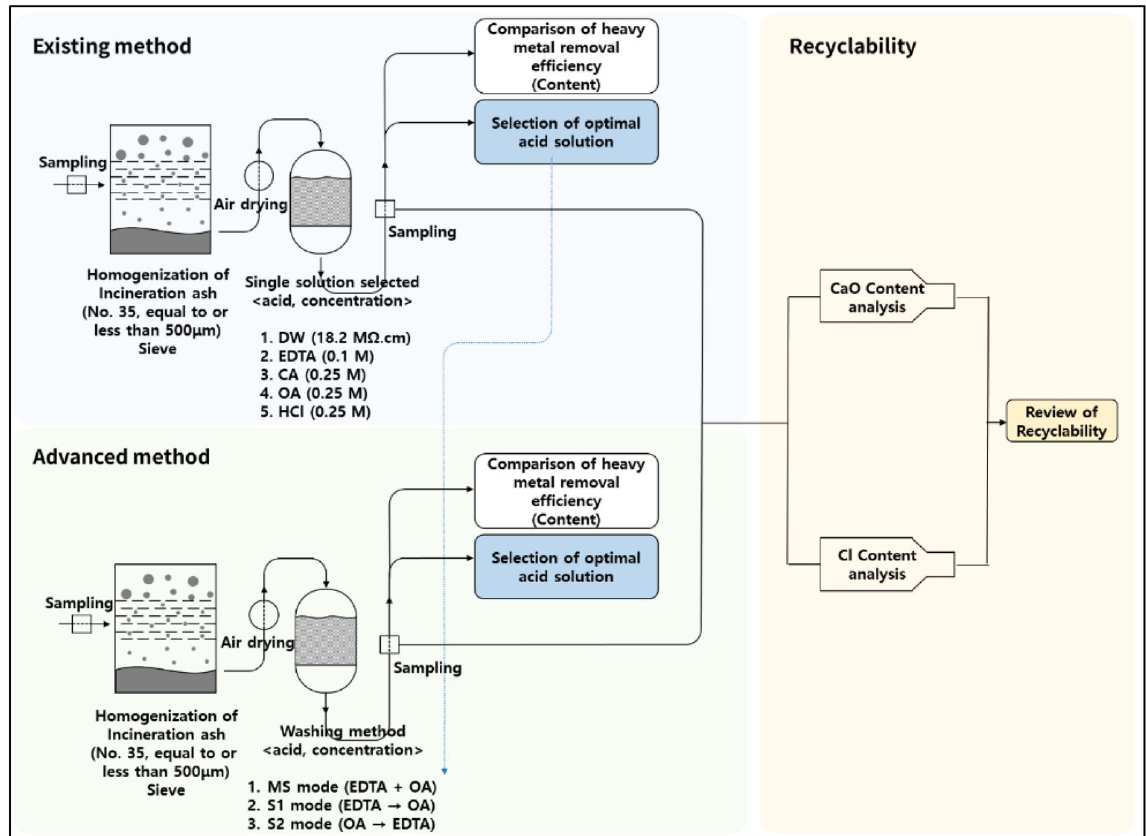
Figure 1. Schematic description of the removal of heavy metals from paper incineration ash. Agent